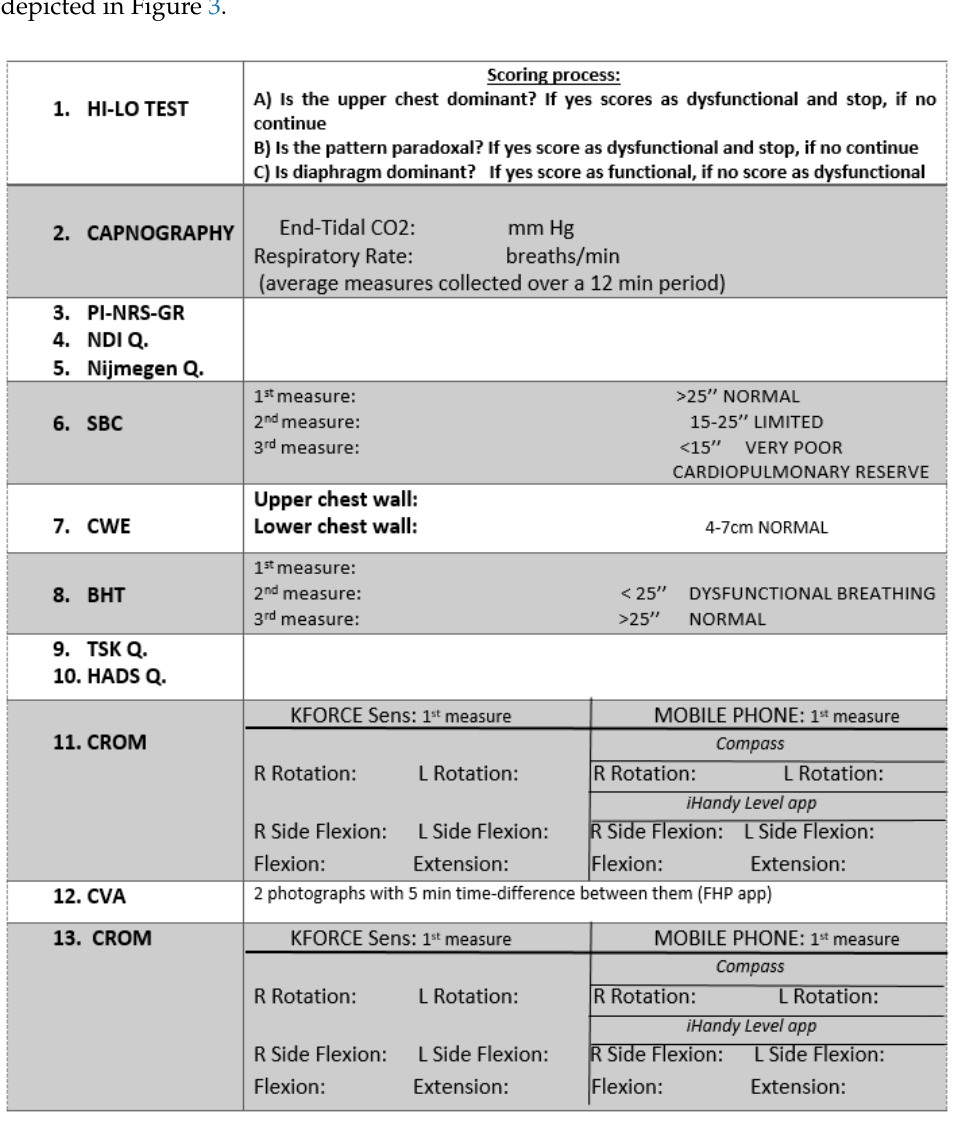
Figure 3. Order of outcome assessments.